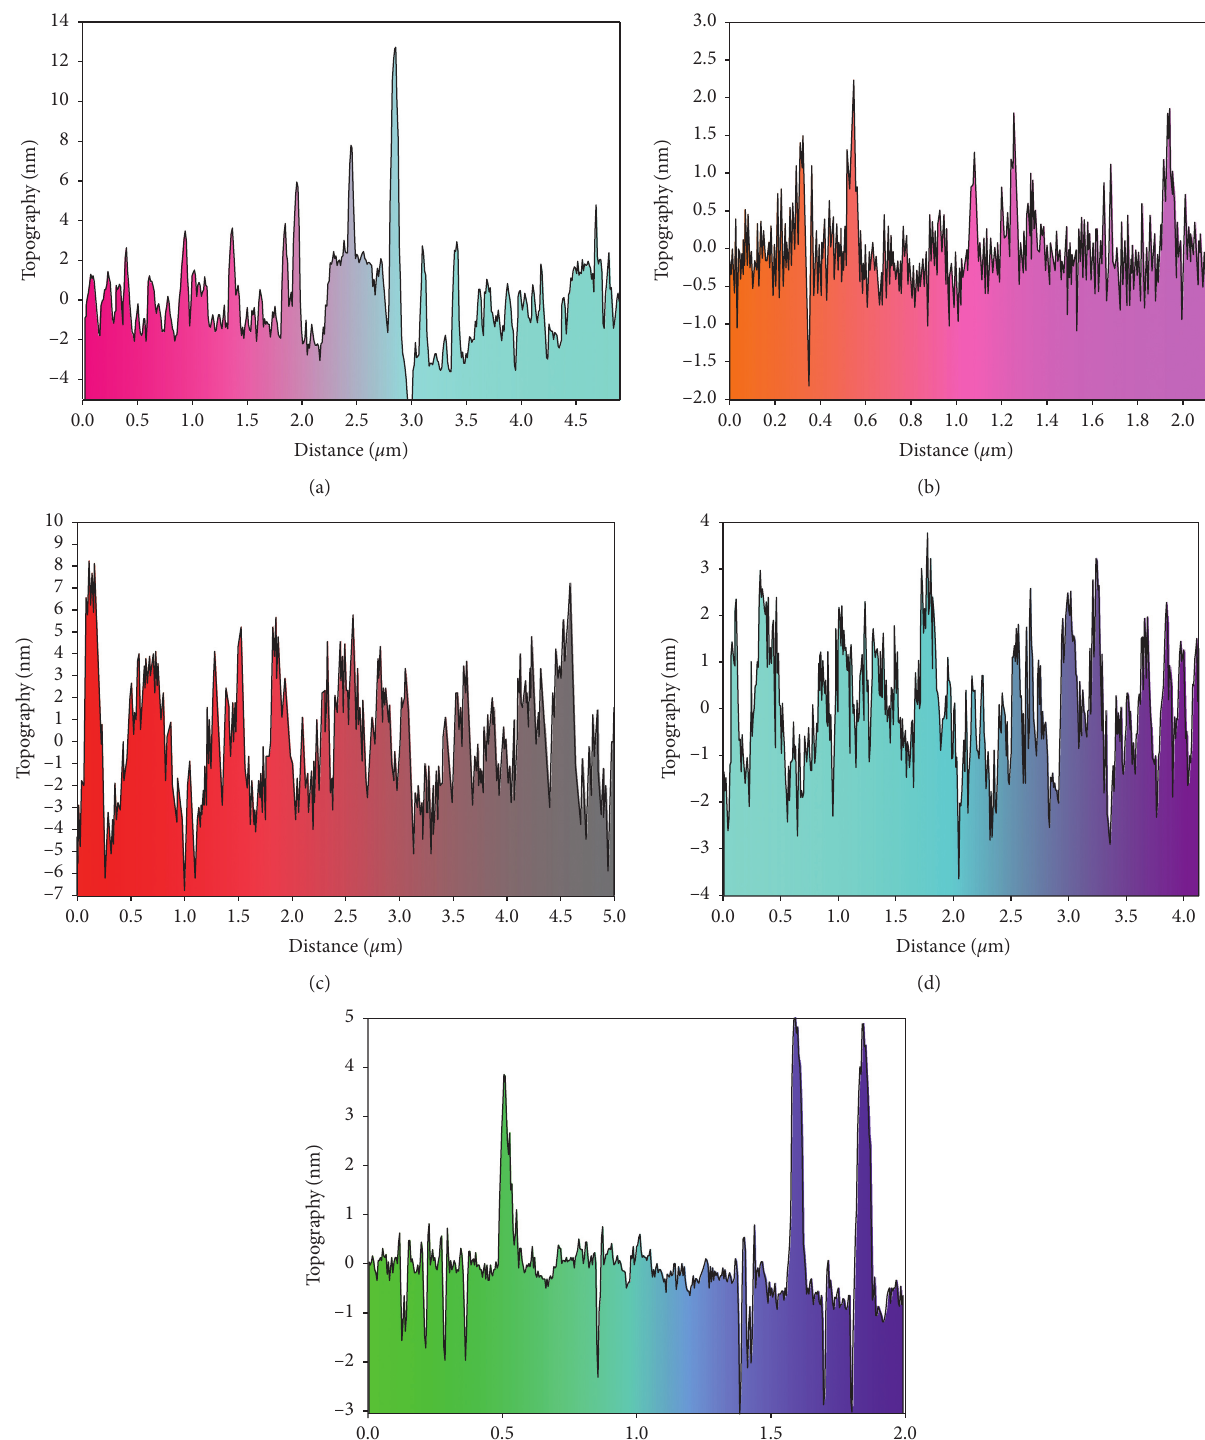
Figure 11: Topography vs. distance analysis of GTC (0% to 40%). (a) GTC-0; (b) GTC-10; (c) GTC-20; (d) GTC-30; (e)